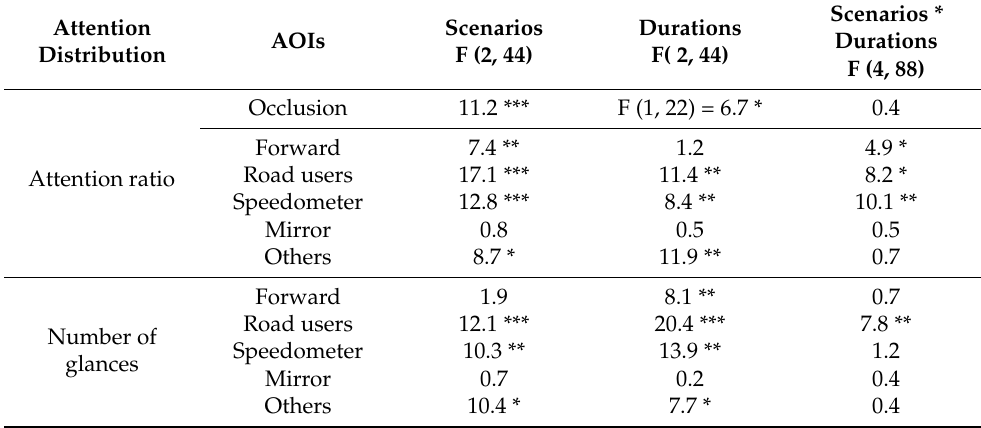
Table 3. F-values and levels of statistical significance for ANOVAs of attention distribution with the factors of occlusion duration and driving scenario in a full factorial design.